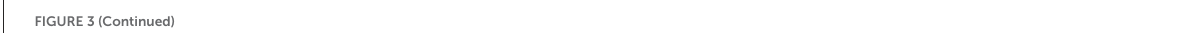
of EGTA are plotted against CaM concentrations. Mean ± s.e.m are shown ( n = 4 for each). *** p < 0.001 for WT vs P212L, at each CaM concentration, Tukey post-hoc analysis followed by ANOVA. (C) Representative images for multi-probe live neuron imaging. FRET ratio images of WT hK2 α (top) and fluorescence images of R-CaMP2 (bottom) in response to local glutamate uncaging (50 photo-uncaging stimulations at 20Hz) are shown. The time from the initiation of the stimulus sequence is indicated in seconds below in each image. (D) hK2 α response traces of WT (blue) and P212L (red) against glutamate uncaging (50 stimulations at 20Hz). Mean ± s.e.m are shown ( n = 19 neurons for WT, n = 19 for P212L). (E–G) Comparison of hK2 α response peak 1 R/R 0 (E) , activation half rise time (F) , deactivation half decay time (G) between WT (blue open square) and P212L (red filled circle). Each plot represents data from each individual neurons, and black bar represents the mean. ** p < 0.01, unpaired t -test, n = 19 for WT n = 19 for P212L. (H) R-CaMP2 response traces in neurons co-transfected with hK2 α WT (blue) and hK2 α P212L (red) against glutamate uncaging (50 stimulations at 20Hz). Mean ± s.e.m are shown by line and shaded areas, respectively ( n = 19 neurons for WT, n = 19 for P212L). (I–K) Comparison of R-CaMP2 response peak amplitude (I) , activation half rise time (J) , deactivation half decay time (K) between neurons co-transfected with hK2 α WT (blue open square) and hK2 α P212L (red filled circle). Each plot represents data from each individual neuron, and the black bar represents the mean. n.s., not significant, unpaired t -test ( n = 19 neurons for WT, n = 19